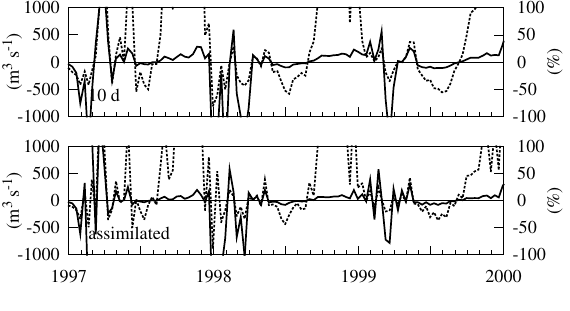
Fig. 6c. Absolute (solid line) and relative (dashed line) forecast error for the Luangwa watershed for the different forecast periods and the assimilation